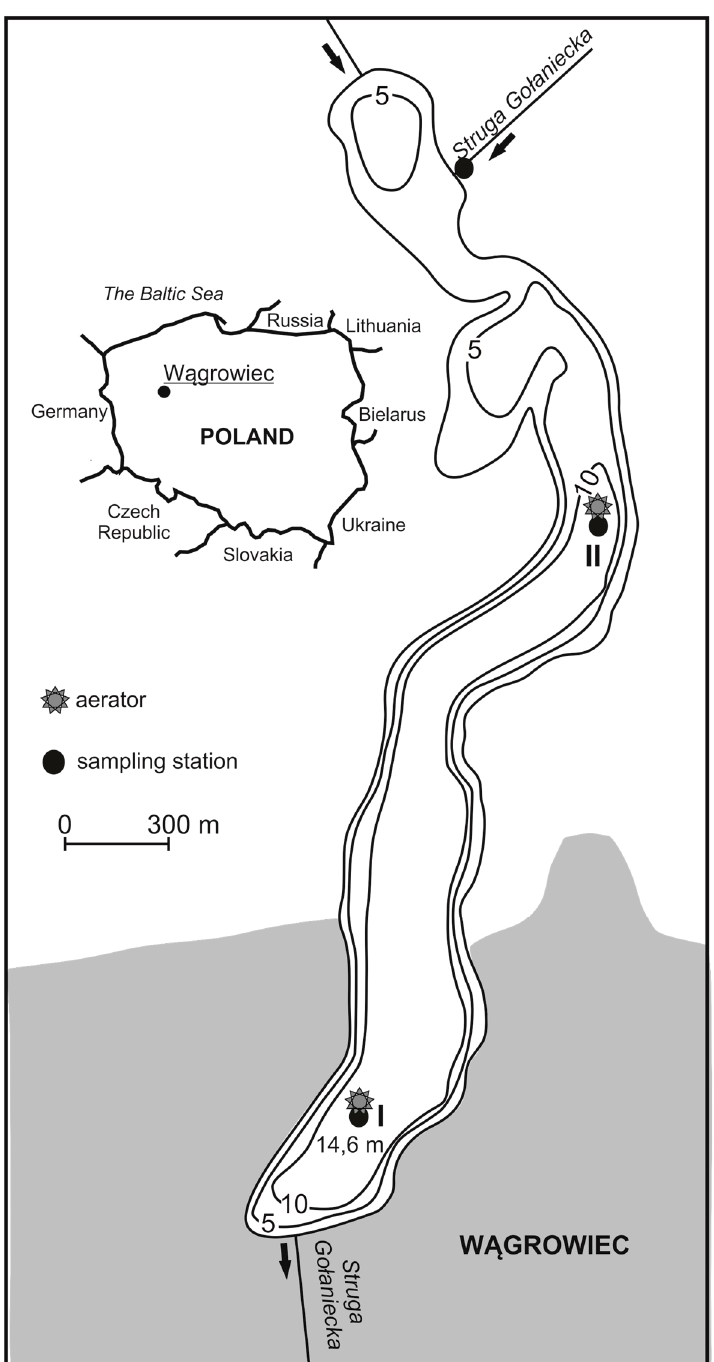
Figure 1. The location of sampling stations and aerators on Lake Durowskie and sampling station on River Struga Go ł aniecka.